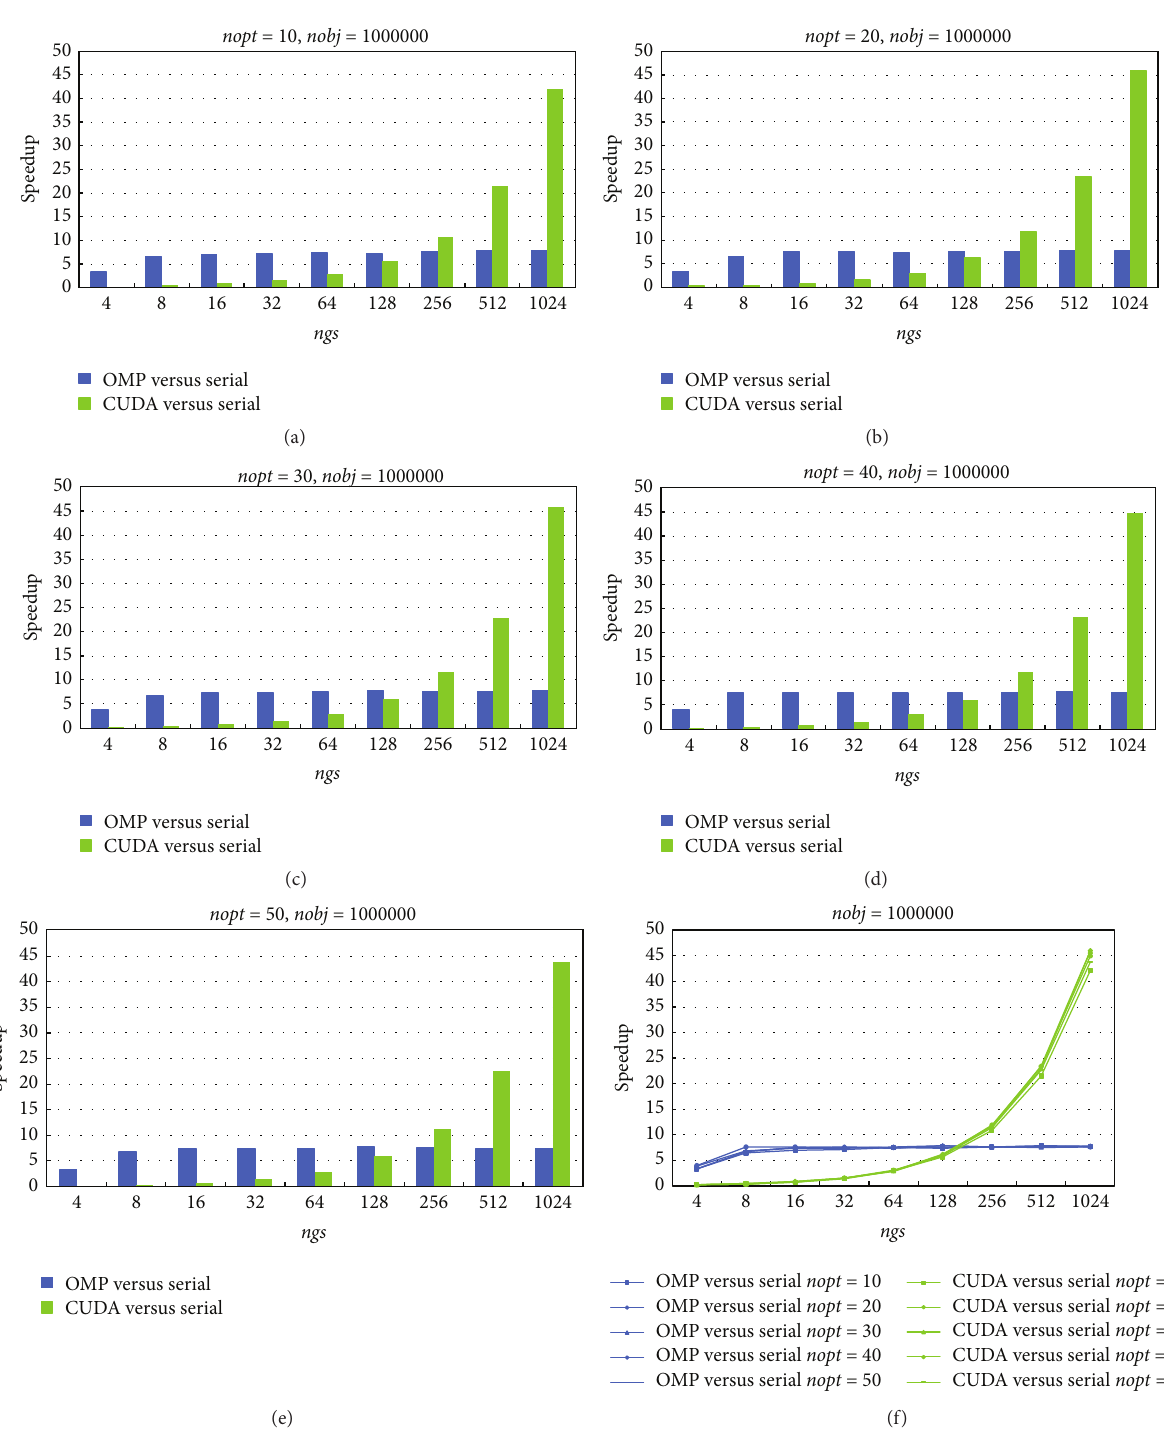
Figure 8: Speedup ratio of the parallel SCE-UA versus the serial